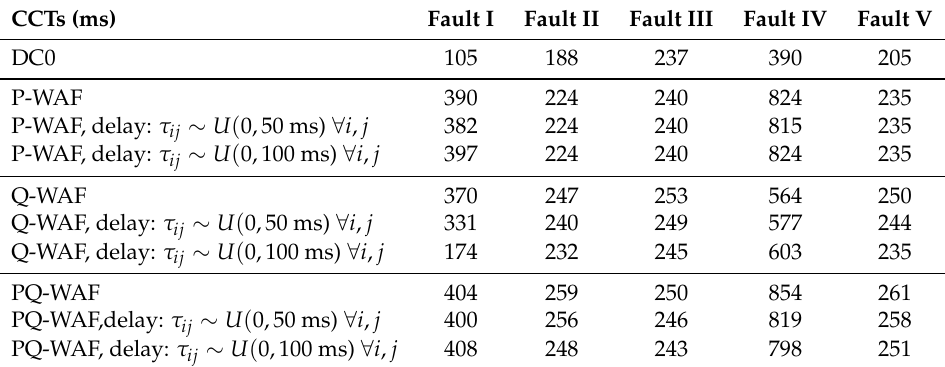
Table 13. Case C. CCT. Effect of communication latency.